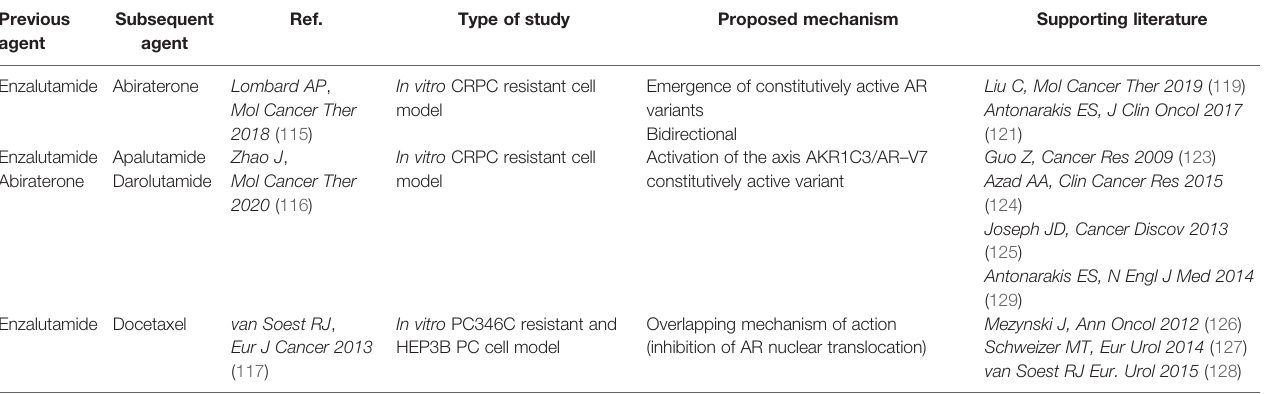
TABLE 4 | Cross – resistance in AR – targeted